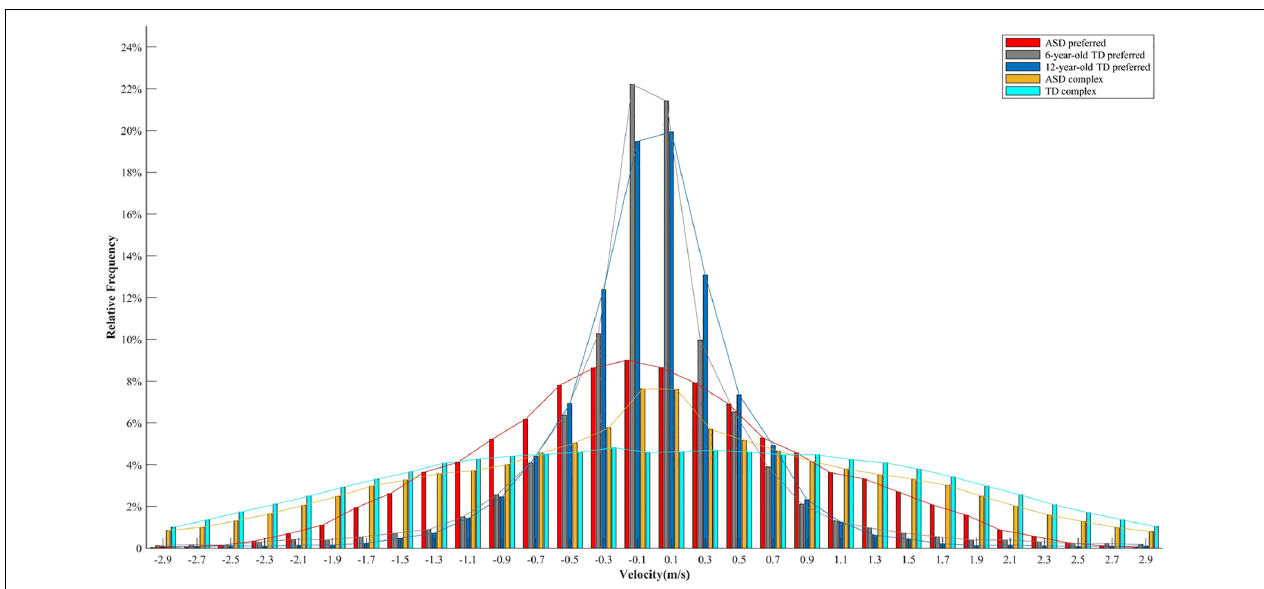
FIGURE 5 | Velocity distributions for the preferred movement in 6-year-old children with TD, 12-year-old children with TD, and children with ASD, and for the complex movement in children with ASD and children with TD. Each distribution includes velocity values of all the participants in a specific